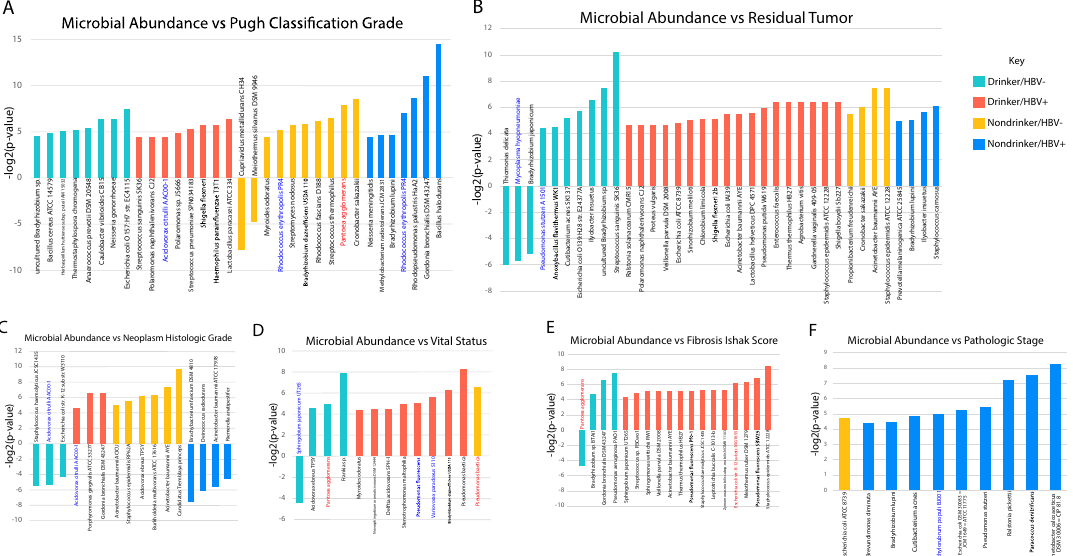
Figure 4. Correlation of microbial abundance to clinical variables. Microbial abundance was compared to ( A ) Pugh Classification grade, ( B ) residual tumor development, ( C ) initial tumor histologic grade, ( D ) vital status, ( E ) fibrosis Ishak score, and ( F ) pathologic stage. Bars with values greater than zero indicate a positive correlation with a worse clinical outcome per variable. Microbes labelled in red are upregulated in the cohort corresponding to the bar color while microbes labelled in blue are